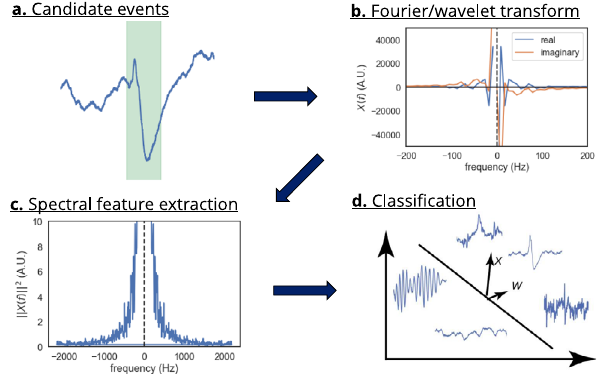
Fig.7|Amachinelearningapproachtopatternclassi fi cation.a Therecordingis segmented into (possibly overlapping) snippets short enough to contain at most one event. b Fourier transform of the event. c Spectral features extracted from Fourier/wavelet transform, followed by postprocessing steps. d Clustering is per- formed on the resulting features. Figure courtesy of Zhenrui